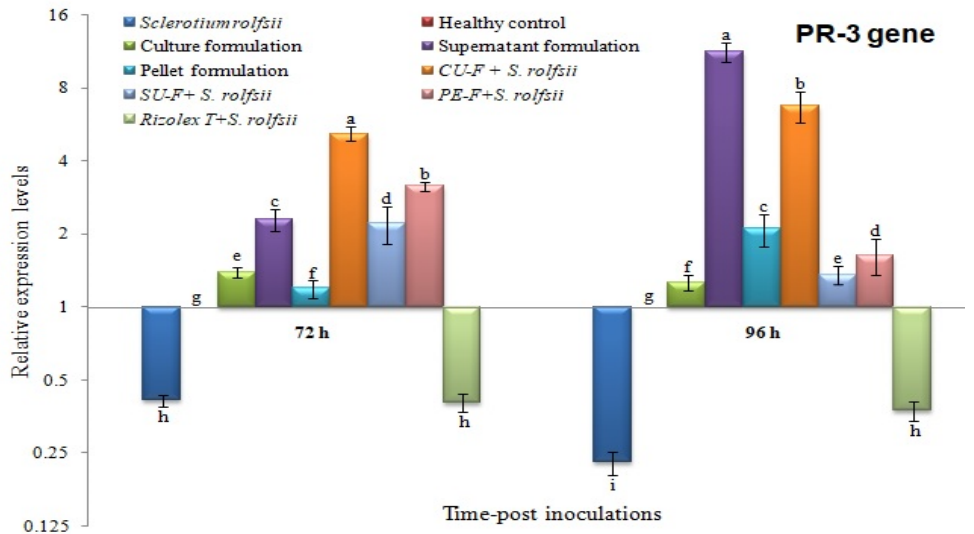
Figure 11. Relative expression levels of PR -3 gene in peanut plants at 72 and 96 h post-inoculation (hpi) of talc-based culture, supernatant, and pellet formulations of Streptomyces cellulosae Actino 48 in soil infected with Sclerotium rolfsii . Compared to the healthy control, the relative expression levels higher than 1 demonstrated an increase in gene expression (upregulation), while values lower than 1 indicated a decrease in expression levels (downregulation).